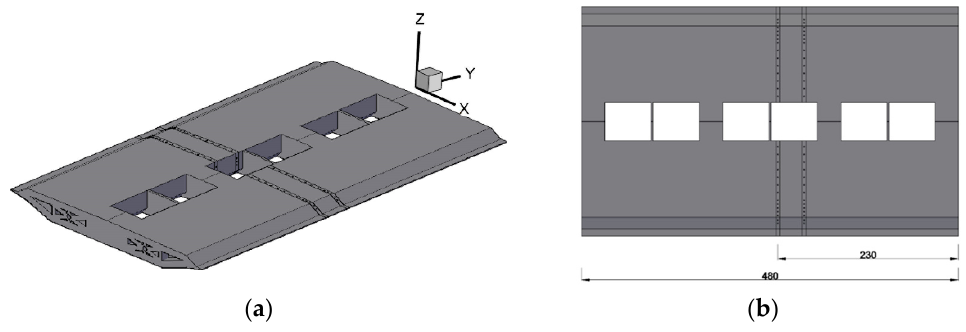
Figure 1. Geometric information of the twin-box girder (unit: m).